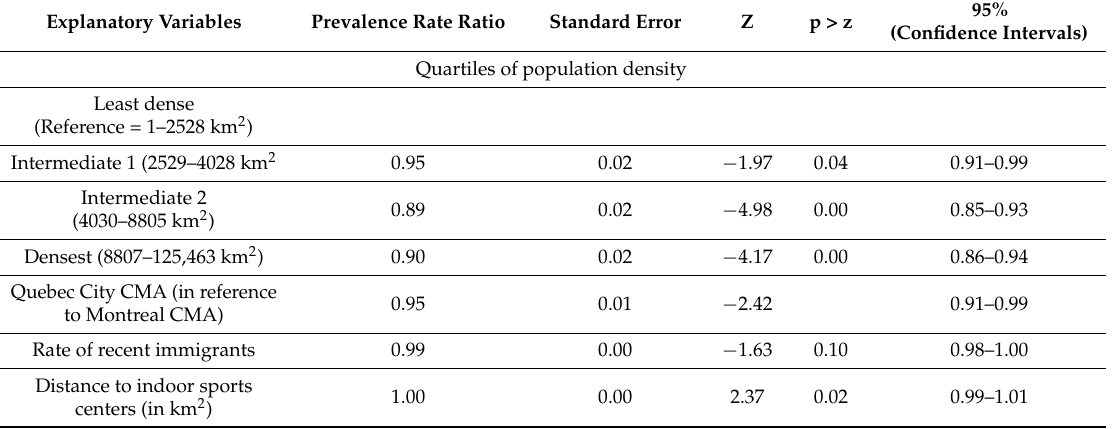
Figure 4. Bivariate local Moran maps of diabetes standardized morbidity rates and distance to green spaces equipped with sport facilities for adults ≥ 20 years living in the CMAs of Montreal and Quebec City, 2006 − 2011. CMA: Central Metropolitan Area; SMR: standardized morbidity rates; GSes: green spaces; High-High: Cluster of highest SMR and highest distance to GSes with sport facilities; Low-Low: Cluster of lowest SMR and lowest distance to GSes with sport facilities.